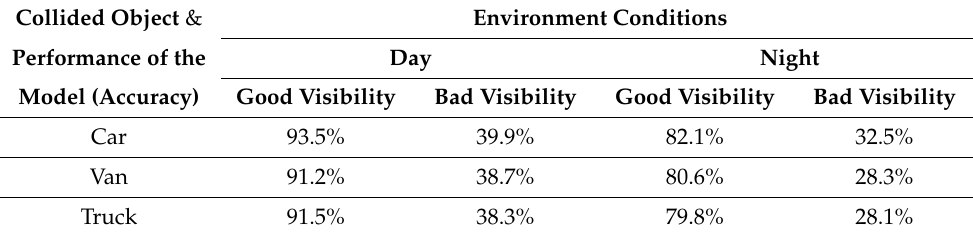
Table 1. Results of the crash detection model’s accuracy. Collided Object